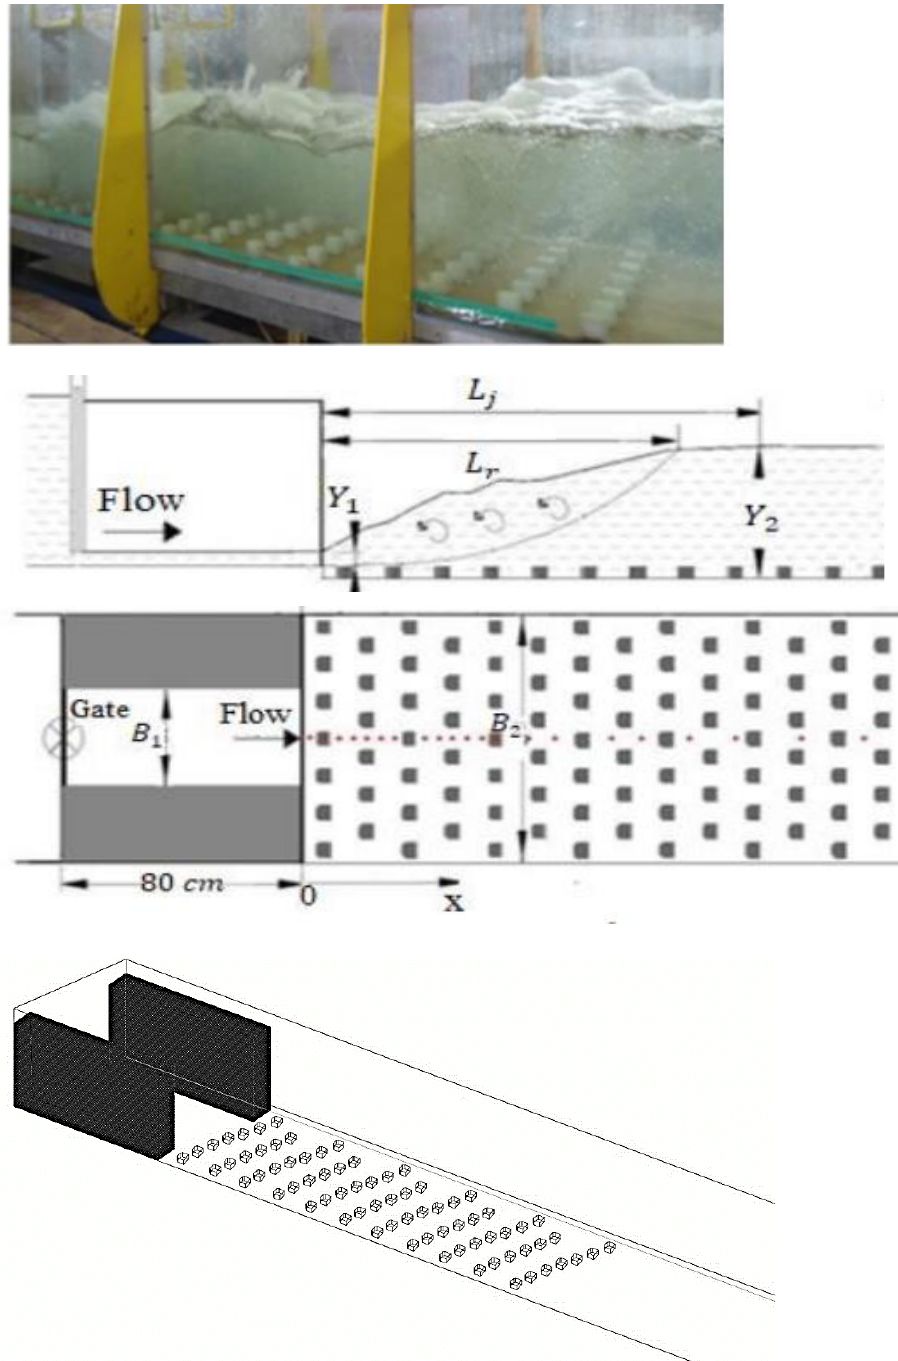
Figure 2. Schematic of the laboratory model.